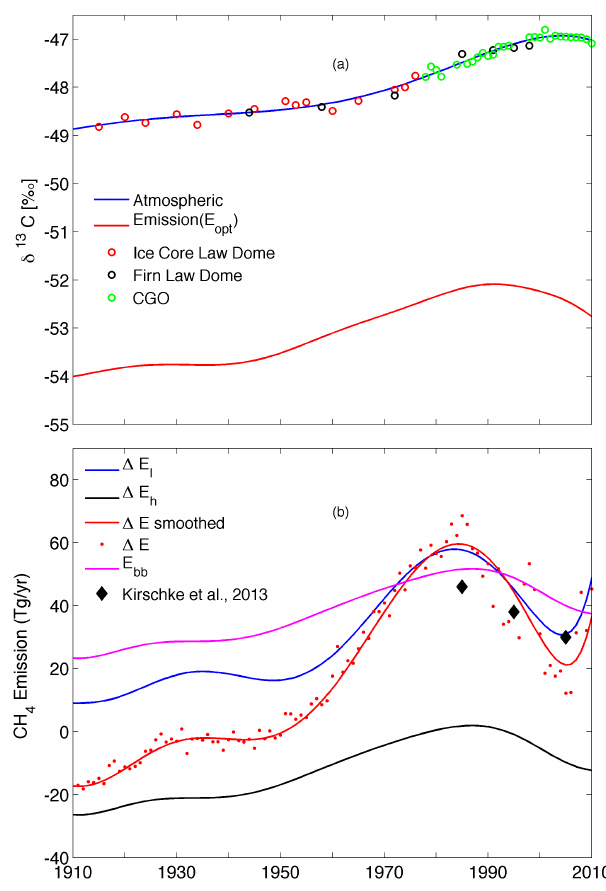
Figure 6. (a) Observations (circles) and smooth time series of δ 13 C atmos and δ 13 C Eopt (b) (cid:49)E (smoothed) is split into (cid:49)E l and (cid:49)E h . Here δ 13 C (cid:49)E and δ 13 C (cid:49)E are assumed to be − 60‰ (bio- l h genic sources, a supplementary source) and − 21.8‰ (biomass burning emission), respectively. Annual average δ 13 C atmos obser- vations from Law Dome (ice core (red circle)/firn air (blue cir- cle) records) and CGO (air archive samples and NOAA-ESRL network direct observations; (magenta circle)) are shown sepa- rately here. The estimated biomass burning emission is given by E bb = 49 . 7 (initial biomass burning emission) + (cid:49)E h (correction term) Tgyr − 1 . A recent estimation of biomass burning emissions (Kirschke et al., 2013) for last three decades is also shown for com- parison (filled